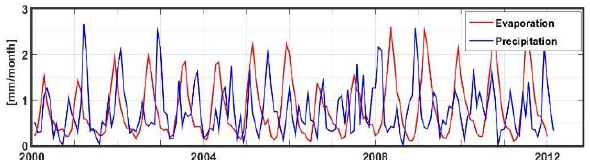
Figure 1. Time series of precipitation and evapotranspiration over Lake Urmia.